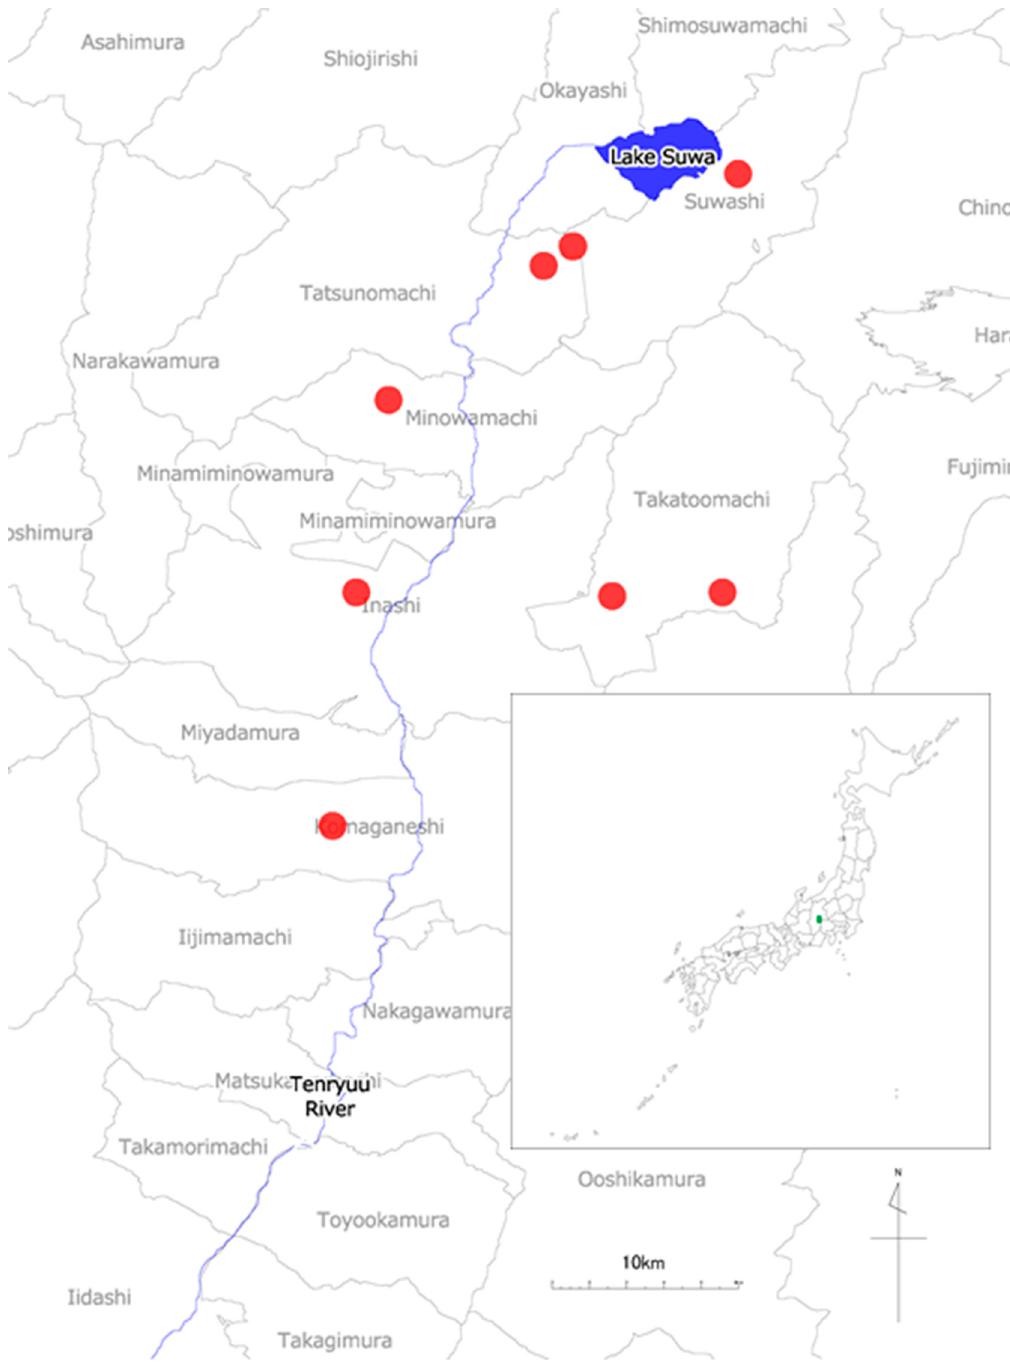
Figure 3. Reference places of the data obtained from a narrow area (Kamiina) (green square area in the map of Japan).